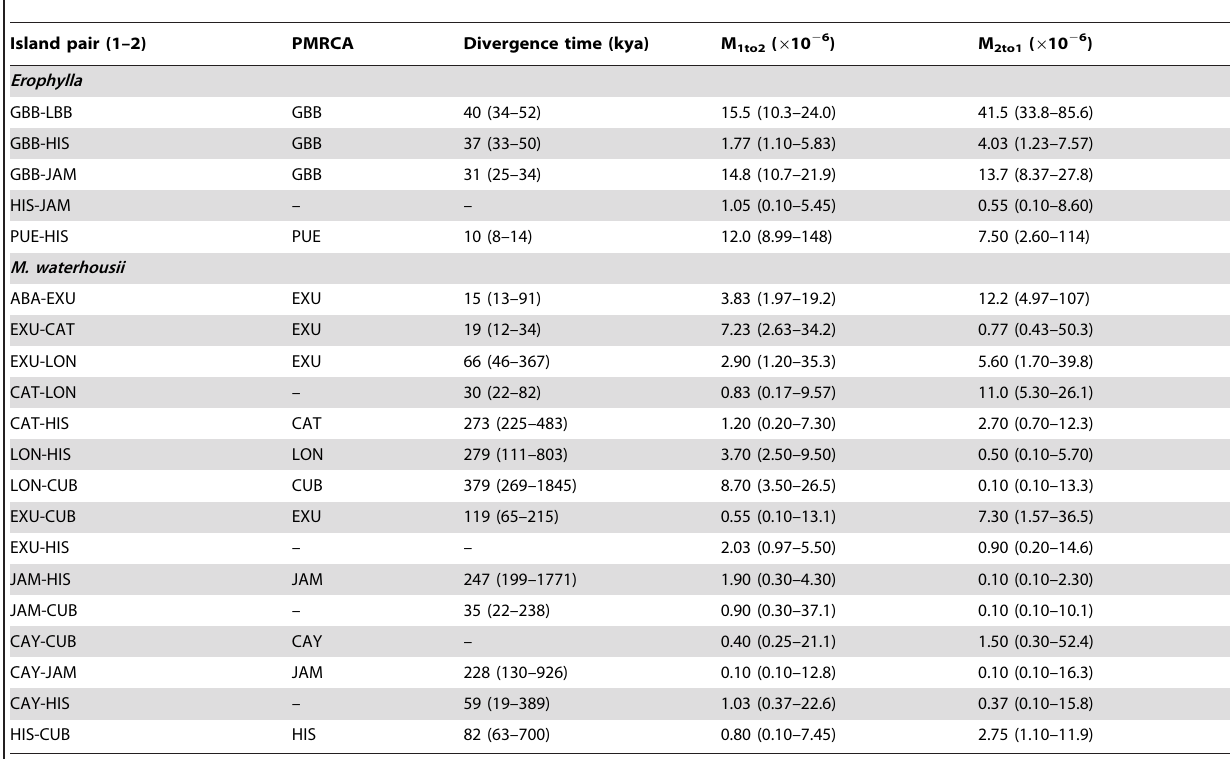
Table 4. Results of IM analyses for Erophylla and M. waterhousii , with 95% CI in